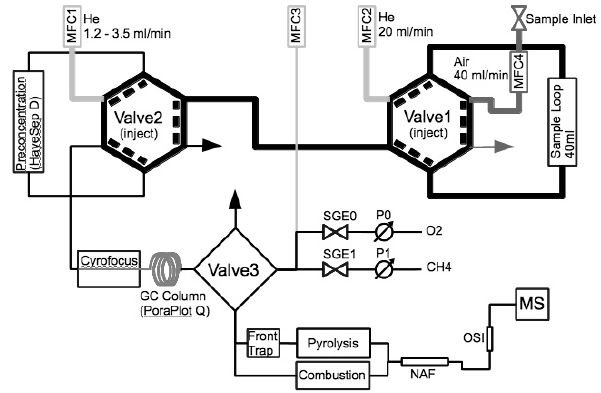
Fig. 1. Scheme of the online methane analysis system: methane from the sample air stored in the sample loop is isolated from other air components by subsequent preconcentration, cryofocussing and gas chromatographic separation. The separated methane is then ei- ther combusted to CO 2 (for δ 13 C measurement) or pyrolyzed to H 2 (for δ D measurement) and injected into the isotope ratio mass spectrometer for isotopic analysis. Three high-purity helium flows (MFC1-3), continuously purging the system, are used as inert car- rier gas. Additionally, O 2 and CH 4 are injected through the valves SGE0 and SGE1 to test and condition the conversion ovens (see text for further details). The thick lines represent 1/8 00 stainless steel tubes and the thin lines are fused-silica capillaries with an inner di- ameter (i.d.) of 0.43mm. The capillaries connecting the pyrolysis furnaces have an i.d. of